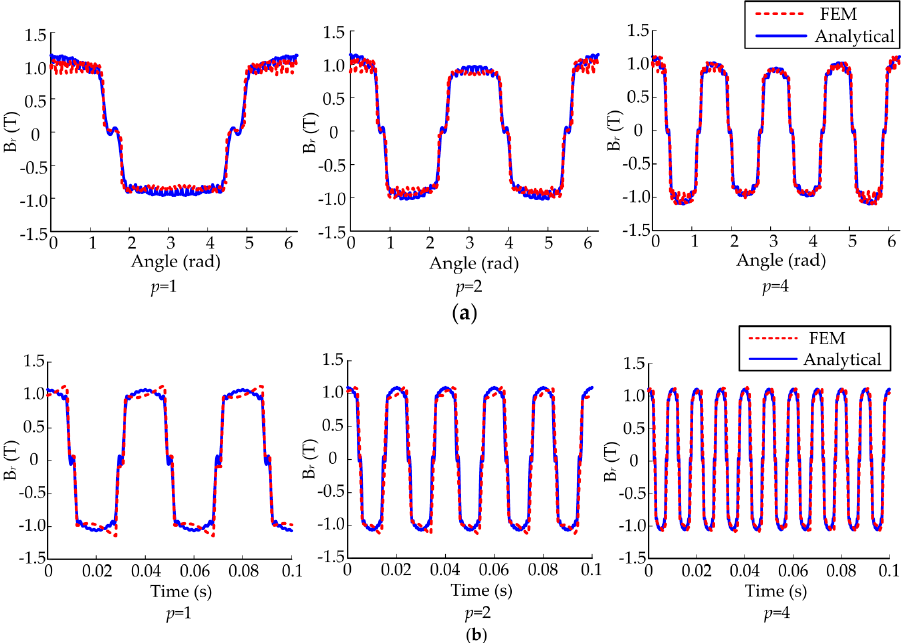
Figure 3. Comparison of field distribution on the rotor surface. ( a ) Field distribution at a given time; ( b ) Field distribution at a given point in time history. FEM: finite element method.